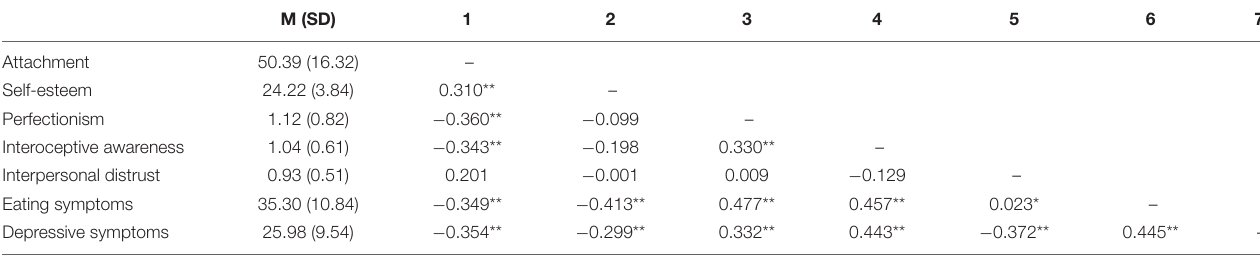
TABLE 1 | Descriptive information for and Pearson’s correlations between main study variables ( n = 93). M (SD)